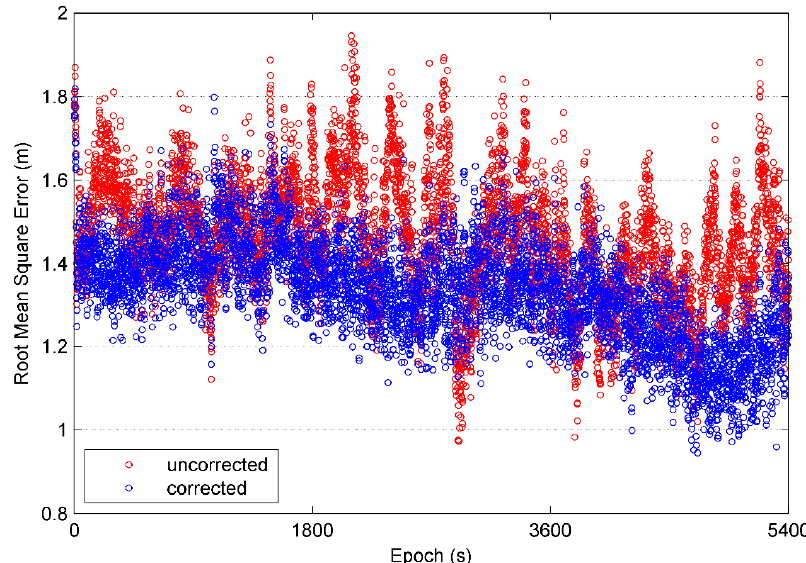
Figure 15. Comparison of root-mean-square error of single point positioning.